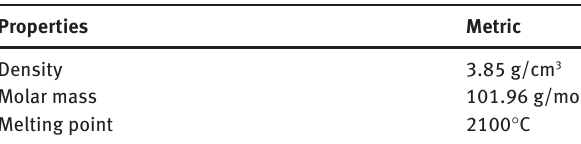
Table 1: Properties of aluminum oxide nanoparticles.